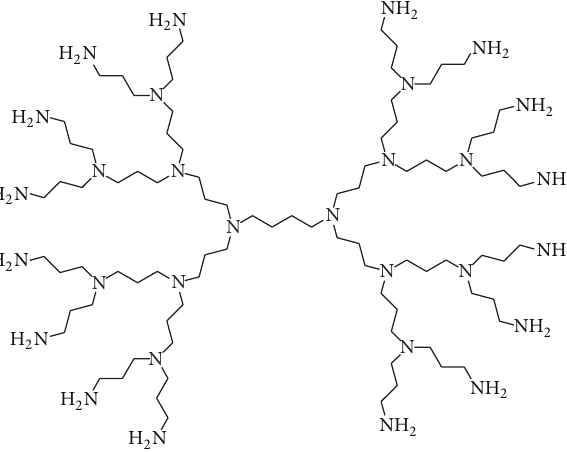
Figure 4: Poly(propylene imine) (PPI) G3